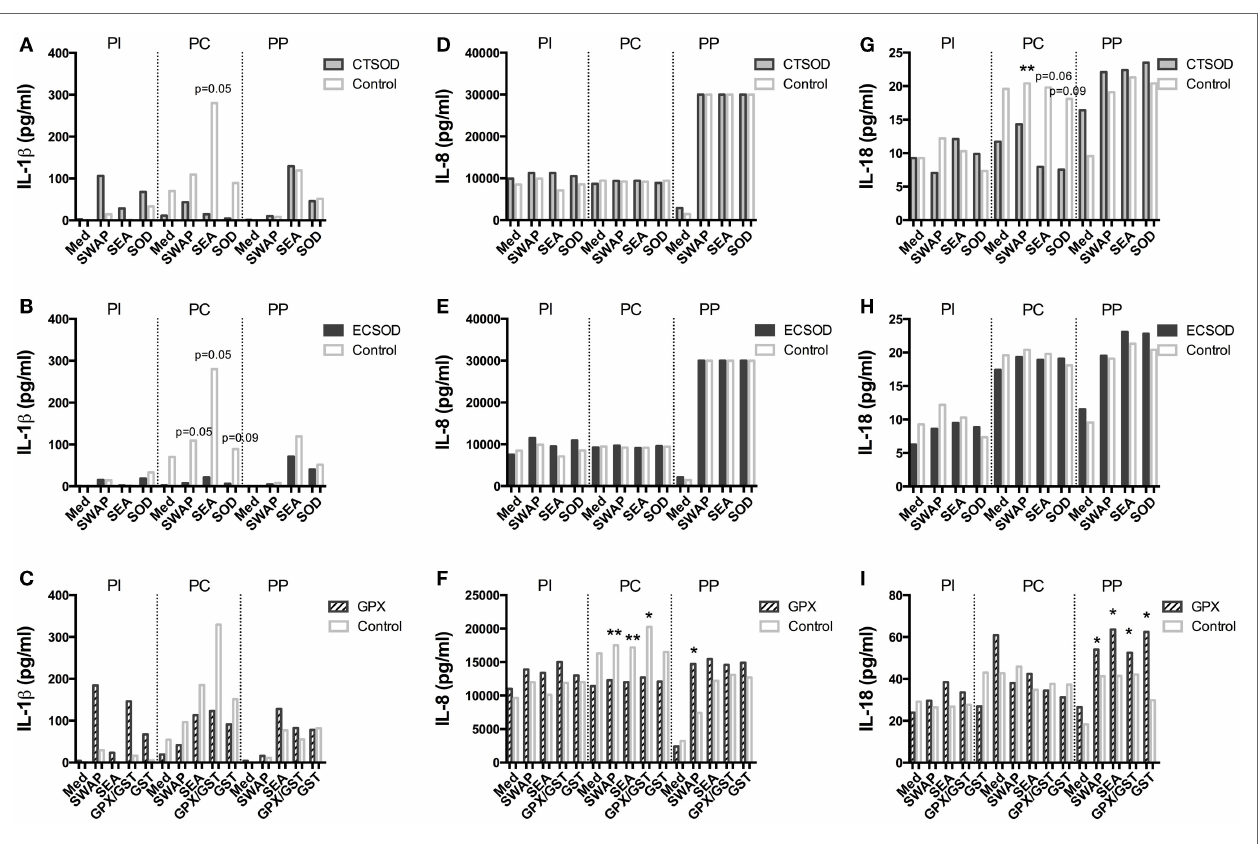
expressed as median of cytokine secretion in five individual supernatants in relation to the Control baboons. Non-parametric (Kruskal–Wallis, Mann– Whitney) tests were applied. Values were considered statistically significant when p < 0.05, and assigned * p = 0.01–0.05; ** p = 0.001–0.01; and *** p = <